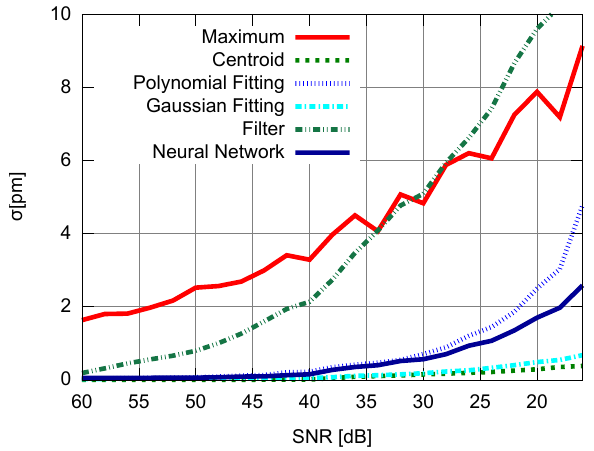
Figure 10. Precision for the uniform modulation profile.